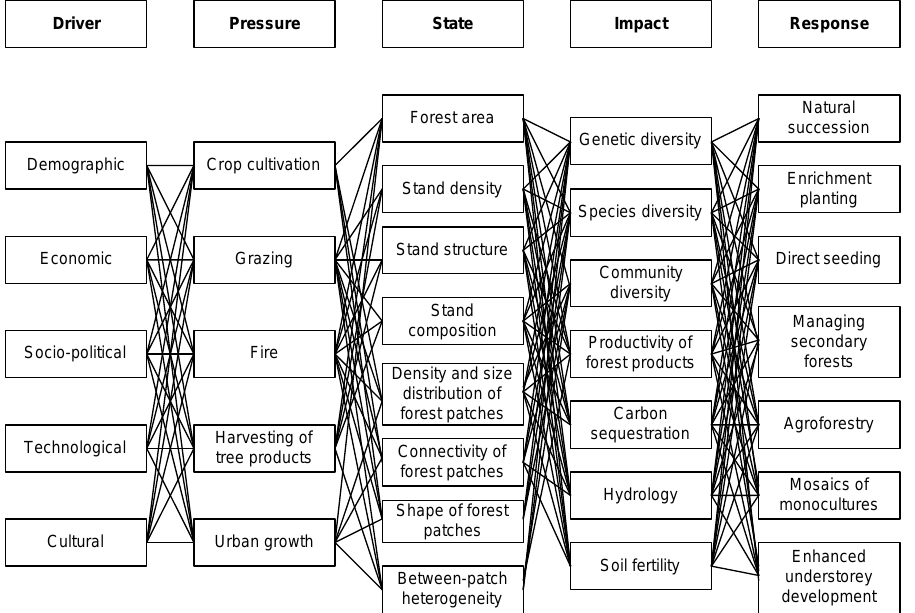
Figure A2.2 Schematic diagram illustrating the context of forest restoration as a response to unsustainable land use practices, according to a DPSIR framework (see